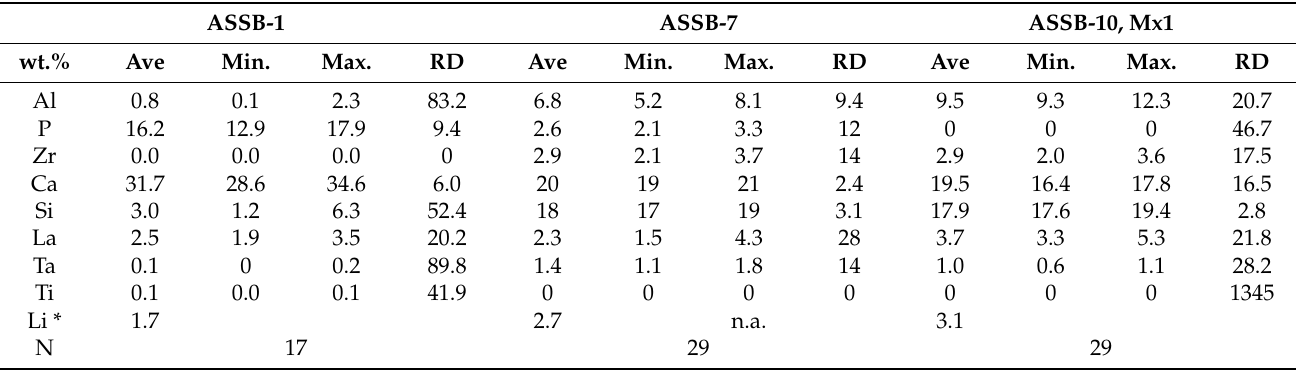
Table A11. Composition of the matrix (wt.%) based on single-point analysis. Ave.: arithmetic average; Min./Max.: lowest/highest measured values; RD: relative standard deviation (%); * calculated value; N: number of measurements; n.a. not applicable (calculated values).